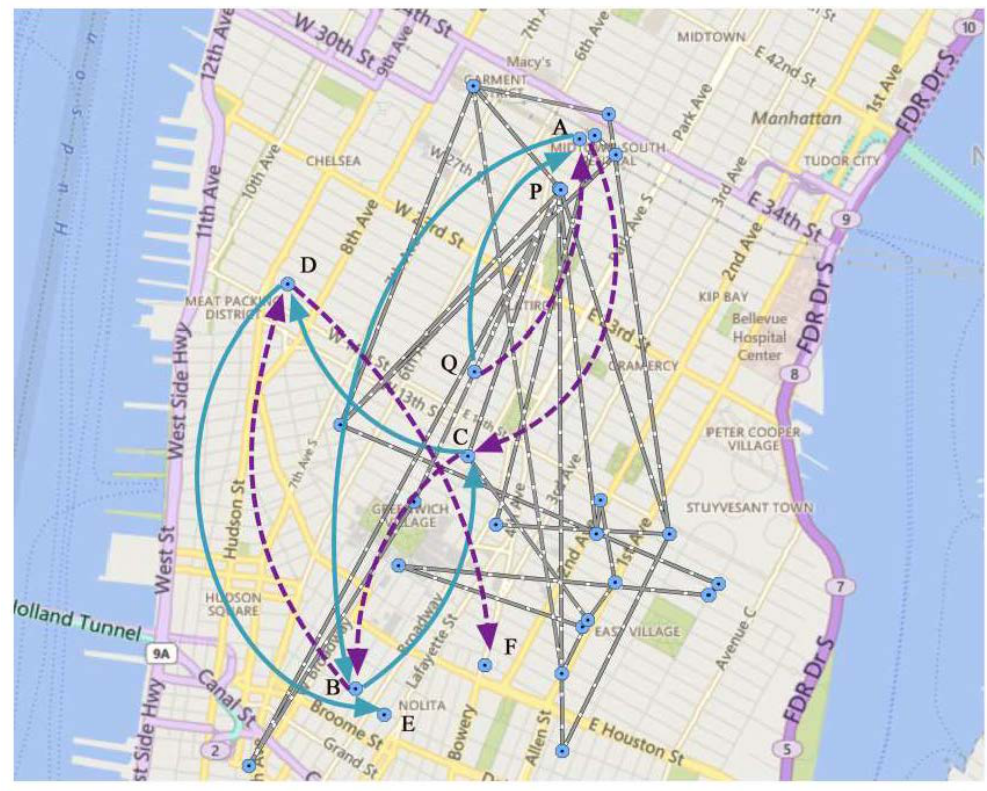
Figure 2. An example of POI sequence